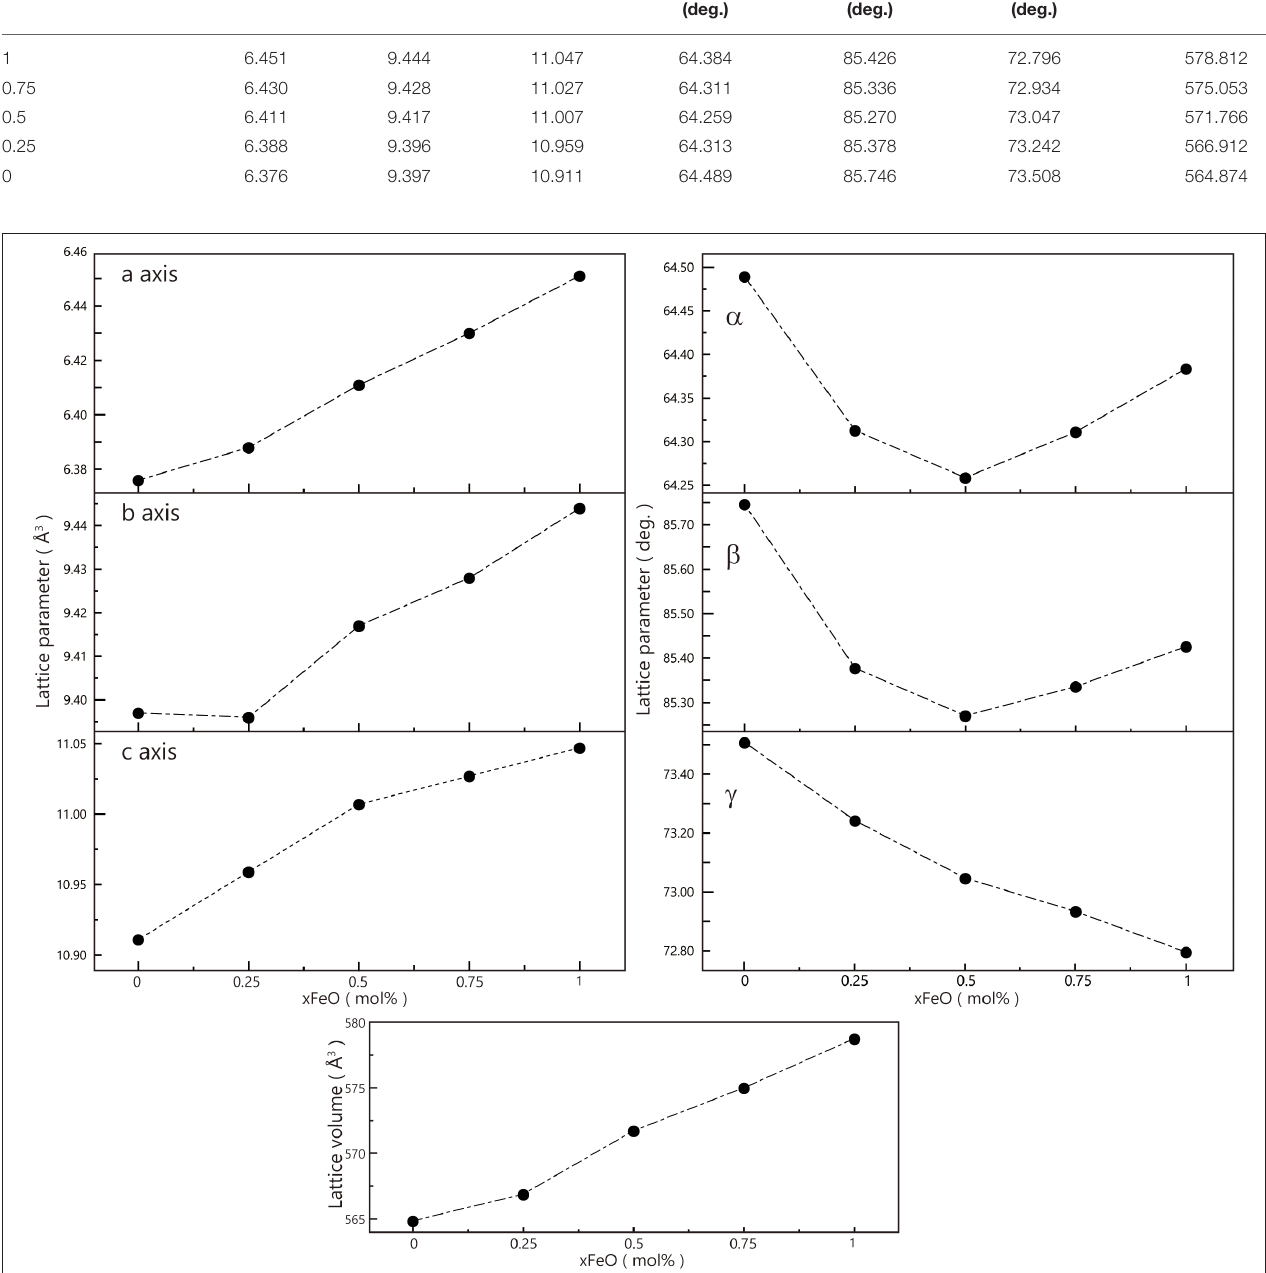
TABLE 1 | Lattice parameters of crystallized Na 2 Fe x Ni 1 − x P 2 O 7 glass-ceramics. Composition x